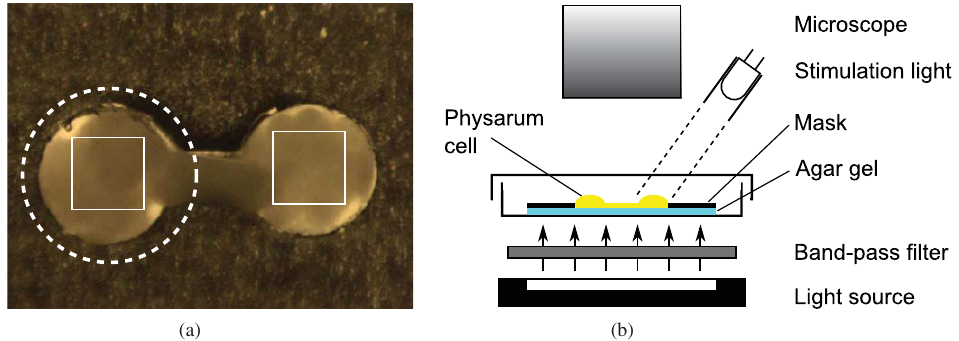
Fig. 4. (a) A dumb-bell shaped plasmodium on a 1.5% agar gel. The black mask surrounding the cell is made of transparency sheet. A dotted circle indicates the area exposed to white light. The areas indicated by two solid squares are used to calculate thickness oscillations of the cell. (b) A schematic illustration of light illumination experiment. The cell is exposed to bandpass-filtered light from the bottom for monitoring and one of two wells is exposed to white LED light from the top for stimulation. The cell is kept in a Petri dish to maintain constant humidity condition.